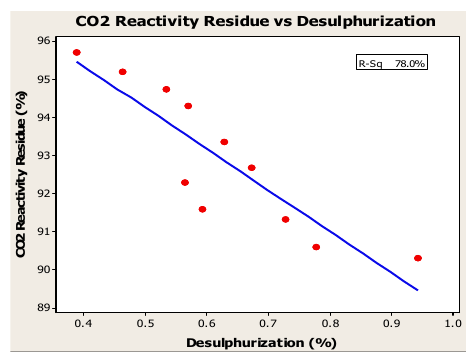
Figure 14. CO2 RR vs. desulfurization.